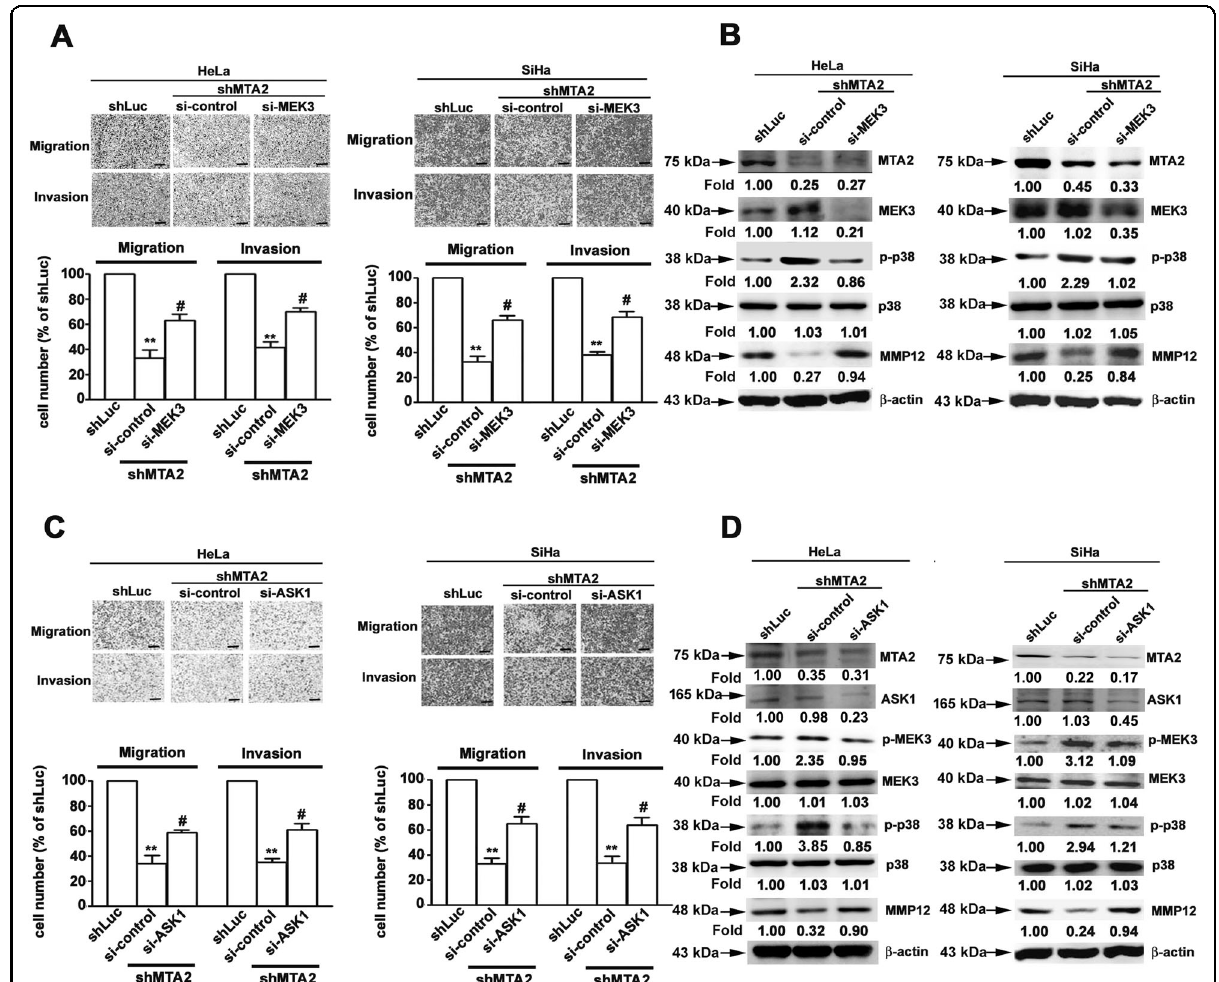
Fig. 4 Involvement of ASK1 and MEK3 in p38-governed downregulation of MMP12 in MTA2-knockdown cervical cancer cells. (A , B) Cells were transfected with shRNA against MTA2 (shMTA2) and siRNA against MEK3 (si-MEK3) and then subjected to ( A ) migration and invasion assay or ( B ) immunodetection of MTA2, MEK3, p38, and MMP12. ( C , D) Cells were transfected with shRNA against MTA2 (shMTA2) and siRNA against ASK1 (si- ASK1) and then subjected to ( C ) migration and invasion assay or ( D ) immunodetection of MTA2, ASK1, MEK3, p38, and MMP12. β -actin signal was used as internal control. ** and #, P < 0.01 and P < 0.05 compared with shLuc and shMTA2 cells alone,